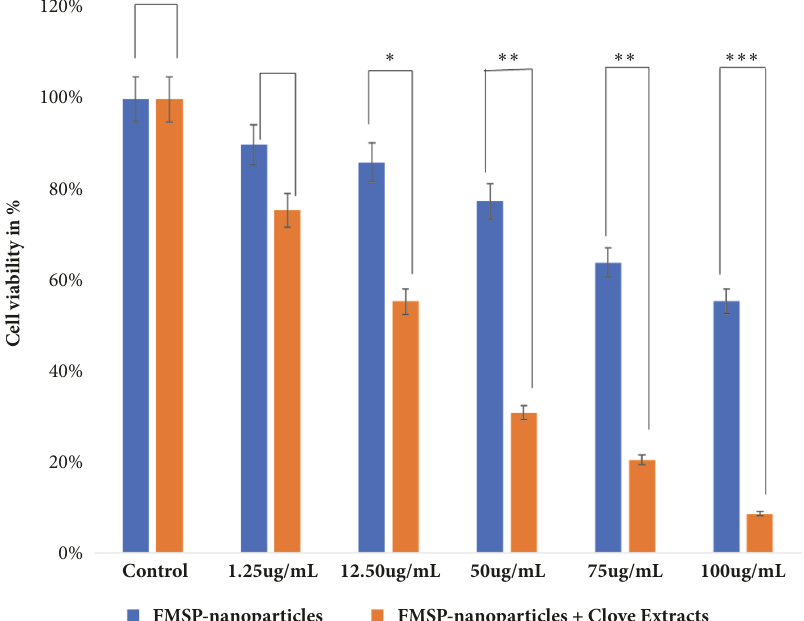
Figure 6: Cell viability analysis by MTT Assay. The MCF-7 cells were treated with FMSP-nanoparticles alone and with clove extracts. FMSP- nanoparticles with concentrations 1.25 𝜇 g/mL, 12.50 𝜇 g/mL, 50 𝜇 g/mL, 75 𝜇 g/mL, and 100 𝜇 g/mL, whereas clove extracts with concentration 100 𝜇 g/mL were used for 48 hrs. Data are the means ± SD of three different experiments. Differences between two treatment groups were analyzed by Student’s t -test where ∗ p < 0.05, ∗∗ p < 0.01; ∗∗∗ p < 0.001; p-values were calculated by Student’s t